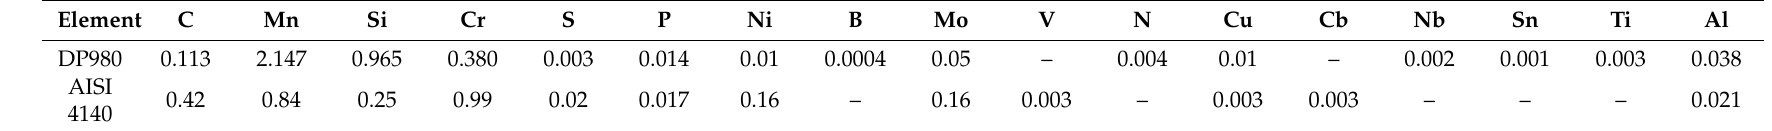
Table 2. Nominal chemical compositions of DP980 and American Iron and Steel Institute (AISI) 4140 (wt%).